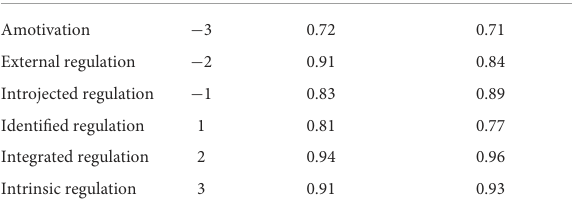
TABLE 3 Cronbach’s alpha reliability for the BREQ-3